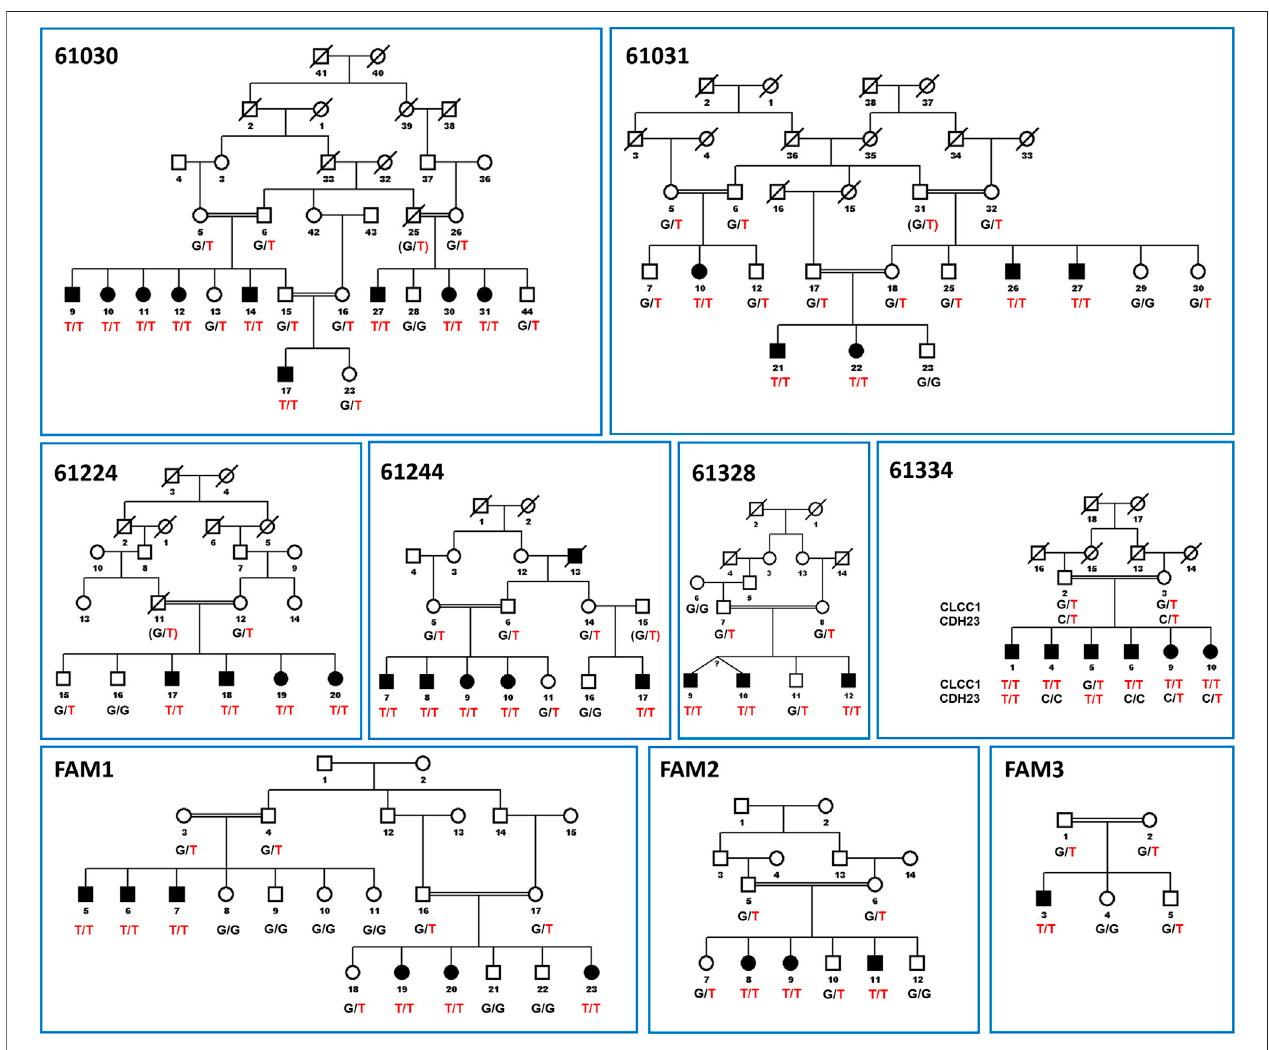
FIGURE1| Pedigree fi gures ofCLCC1 mutationinthe nineconsanguineous familieswith genotypes ofavailable individuals. Thesquaresand the circlesrepresent males and females, respectively. The black- fi lled symbols indicate patients with retinitis pigmentosa, and a symbol with a diagonal line indicates a deceased family member. The candidate variants are listed under each pedigree, and the genotypes of the individuals for the variants are marked below each symbol. The c.75C > A mutationisshowninthe fi gureasNC_000001.11:g.108950376G > TforconsistencywiththegenomicdescriptionoftheSNPindatabasesandin Figure2 . “ T/T ” indicates homozygous variant, “ G/T ” or “ C/T ” indicate heterozygous variants, and “ G/G ” or “ C/C ” indicates homozygous reference alleles for CLCC1 and CDH23 , respectively. CDH23 alleles are shown for Family 61334 as individual fi ve is affected on the basis of inheriting two variant alleles for CDH23 and is only heterozygous for the CLCC1 variant allele, while individual one in that family is homozygous for both variants. Linkage results and SNP haplotypes are shown in Li et al. (Li et al.,